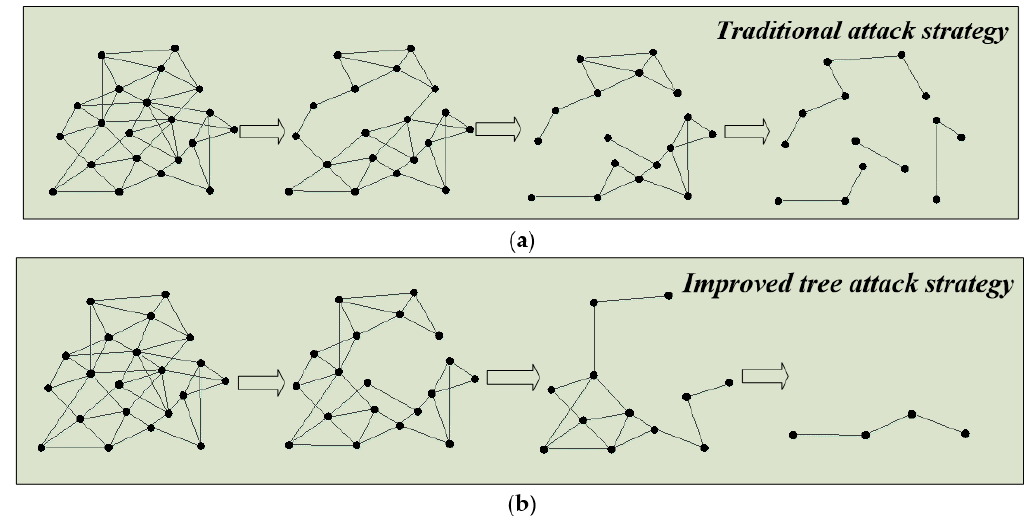
Figure 4. ( a ) Schematic diagram of the traditional attack strategy, ( b ) Schematic diagram of the improved tree attack